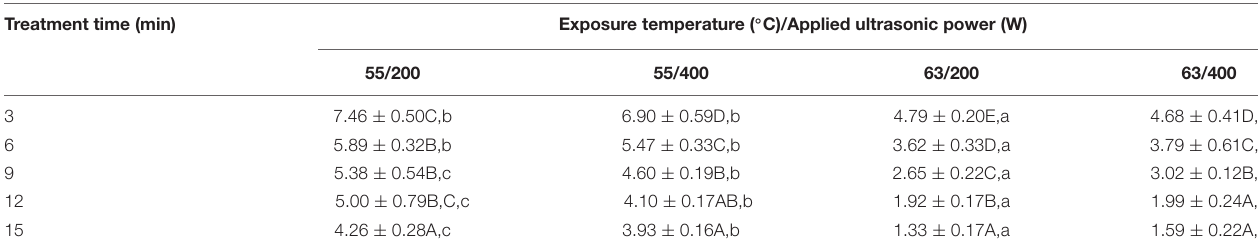
TABLE 1 | Survival concentrations (log 10 CFU/ml) of S. aureus after the 360-degree radiation thermosonication treatment under various conditions. Treatment time (min)